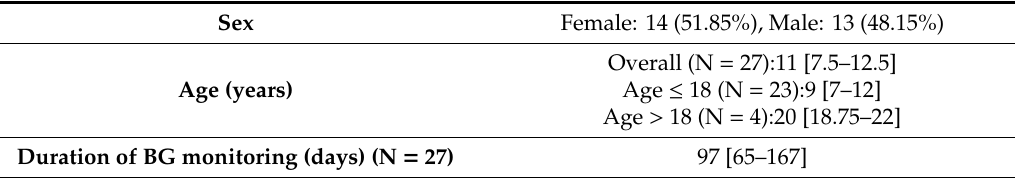
Table 3. Characteristics of the sample. To describe the distributions of the subjects’ age and of the duration of the monitoring, we provided the median value for each variable and, in brackets, the interquartile range.